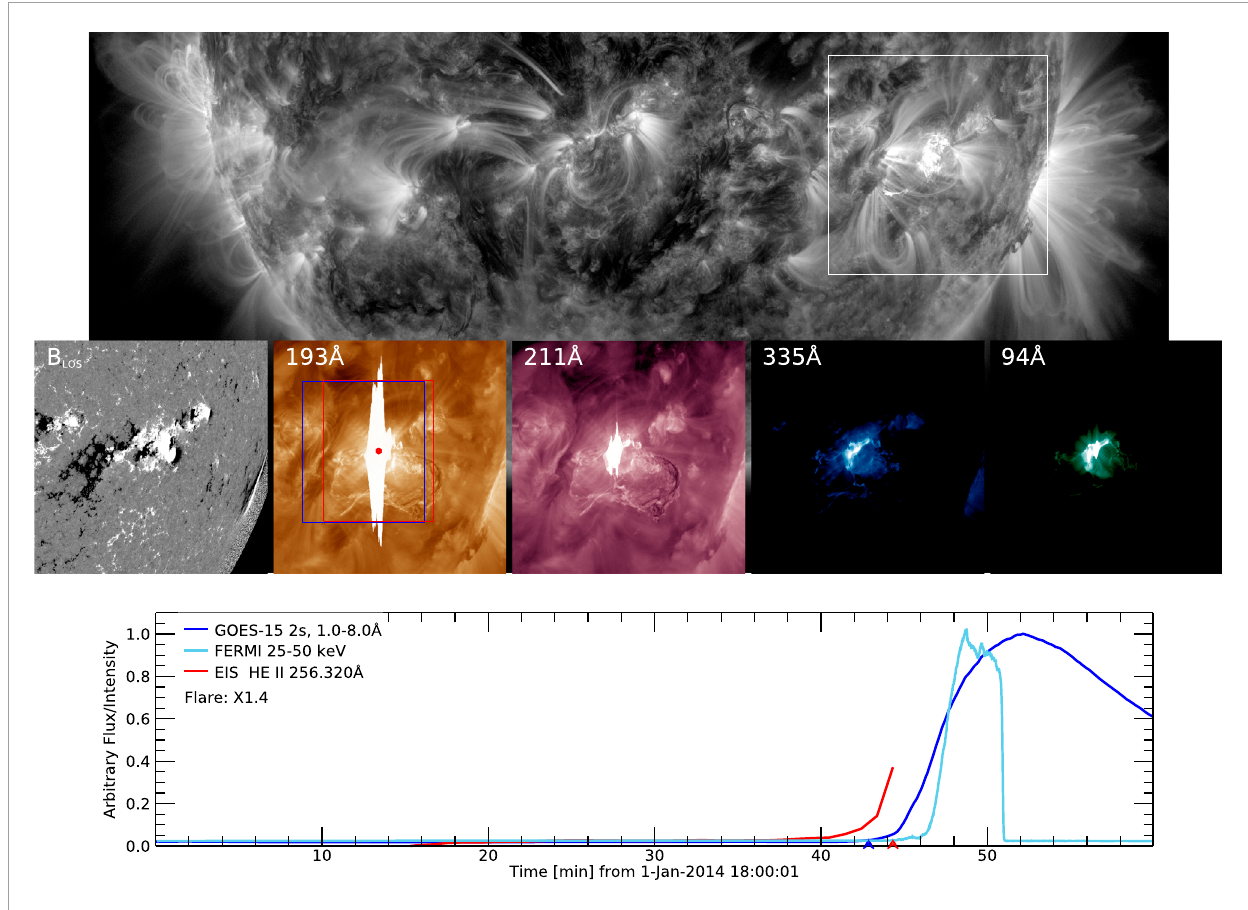
FIGURE 1 An example flare from our sample. The grey scale background is an AIA 171 Å image taken at 18:44:32 UT on 2014, January 1. The flare host AR 11936 is highlighted by the white box and the FOV corresponds to the cutouts in the middle row showing (left to right) an HMI line-of-sight magnetogram, AIA 193 Å, 211 Å, 335 Å, and 94 Å images. The AIA images are dominated by Fe lines forming at temperatures of 1.4, 1.8, 2.5, and 7.1 MK in flaring conditions, respectively. The blue box shows the FOV of the EIS wide-slit flare hunter study. Once triggered, EIS switches to the designated response study centered on the detected flare site (red dot) with a different FOV (red box). The bottom row shows the GOES soft X-ray (SXR) light curve (blue), Fermi hard X-ray (HXR) light curve (sky blue), and EIS He II 256.32 Å mean intensity of the FOV. The abrupt end of the red line indicates when EIS was triggered. This is also indicated by the red arrow. The blue arrow shows the start time of the flare derived from the SXR data (see text). The X-axis labels give the time in minutes from the start time shown in the axis